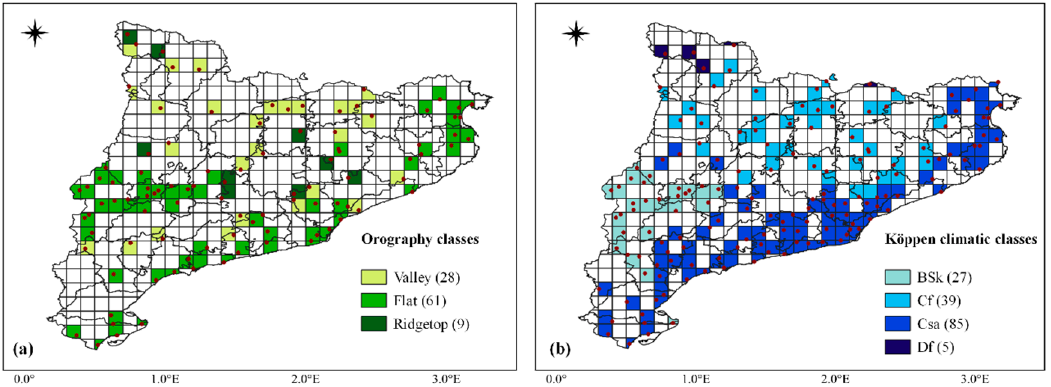
Figure 3. Distribution of IMERG pixels and stations (red dots) classified according to ( a ) orography ( b ) Köppen climate classification used for validation. The numbers in brackets represent the number of stations under that classification.